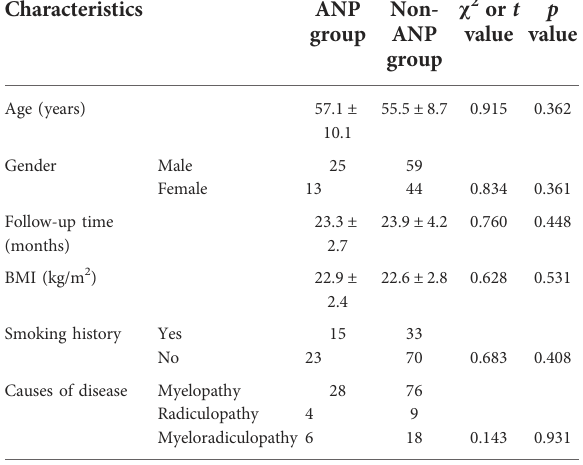
TABLE 1 Characteristics of the enrolled groups treated with single- door laminoplasty.